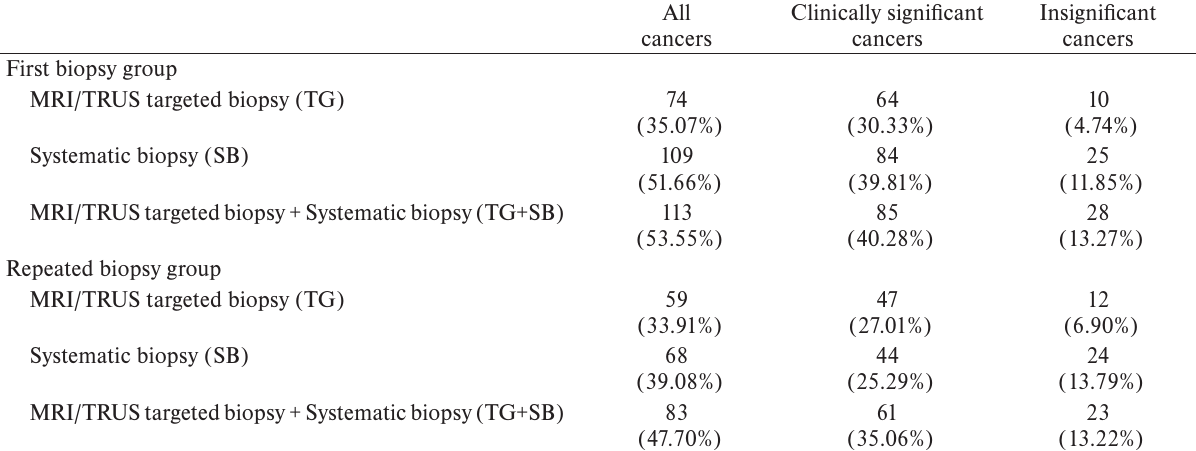
Table 2. Detection rates of clinically significant and insignificant prostate cancer stratified to the first and repeated biopsy groups.